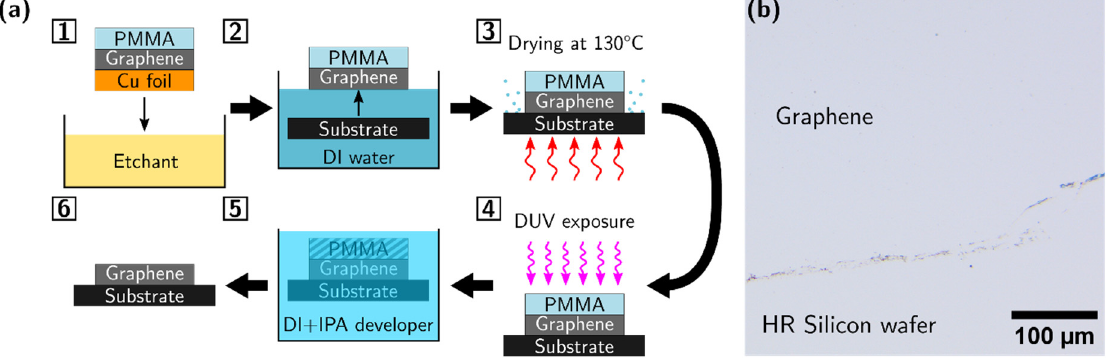
Figure 4. ( a ) Schematic of graphene wet transfer and PMMA removal processing steps. ( b ) Optical microscope image of graphene edge